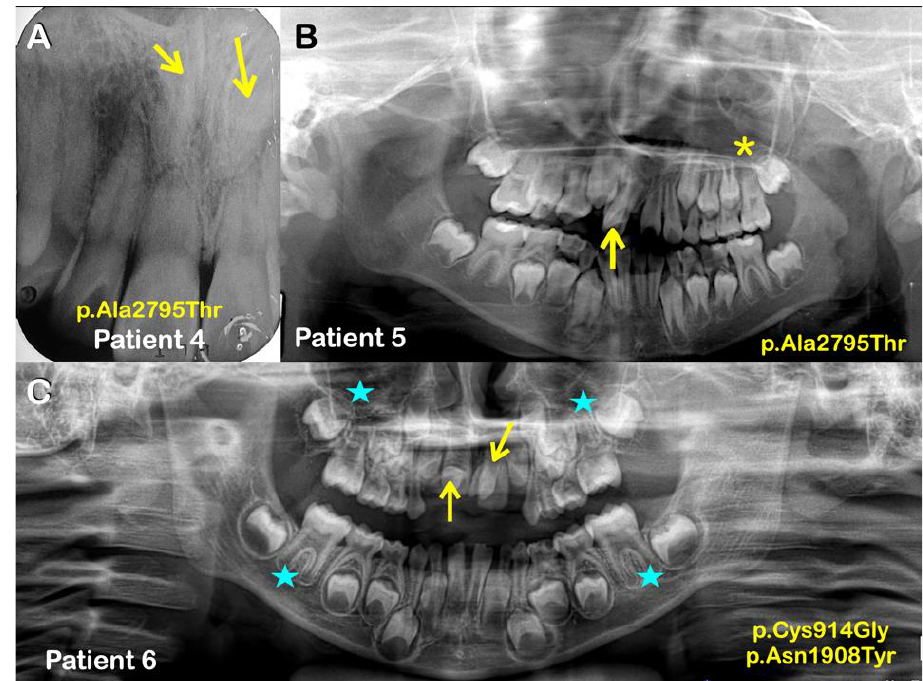
Figure 1. ( A ) Patient 1. Panoramic radiograph showing a supernumerary left mandibular premolar (arrow). ( B ) Patient 2. Occlusal radiograph showing double mesiodentes (arrows). ( C ) Patient 3. Panoramic radiograph showing a mesiodens (arrow).